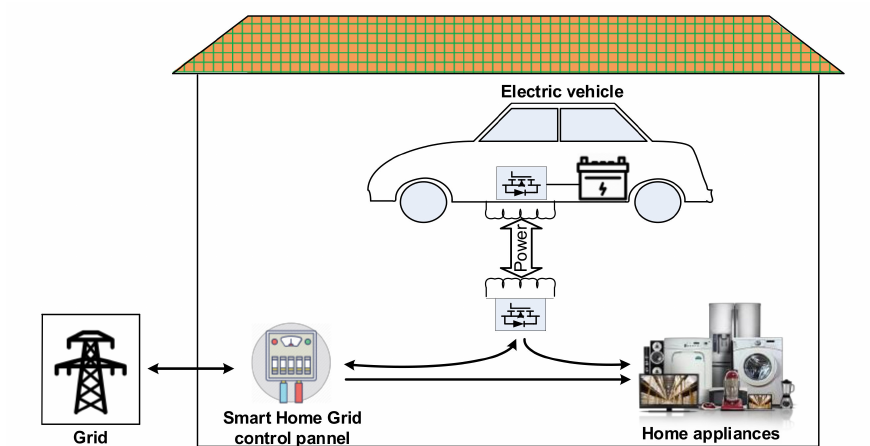
Figure 1. BWV2H scheme of principle.